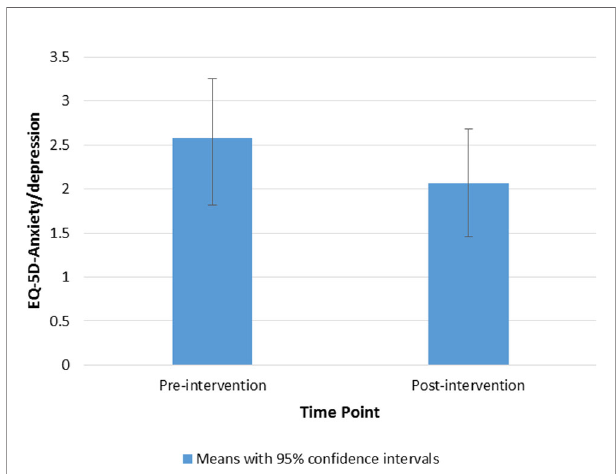
FIGURE 4 | Bar chart to show means and 95% con fi dence intervals of EuroQual-5D-Anxiety/depression subscale ratings from pre- to post-